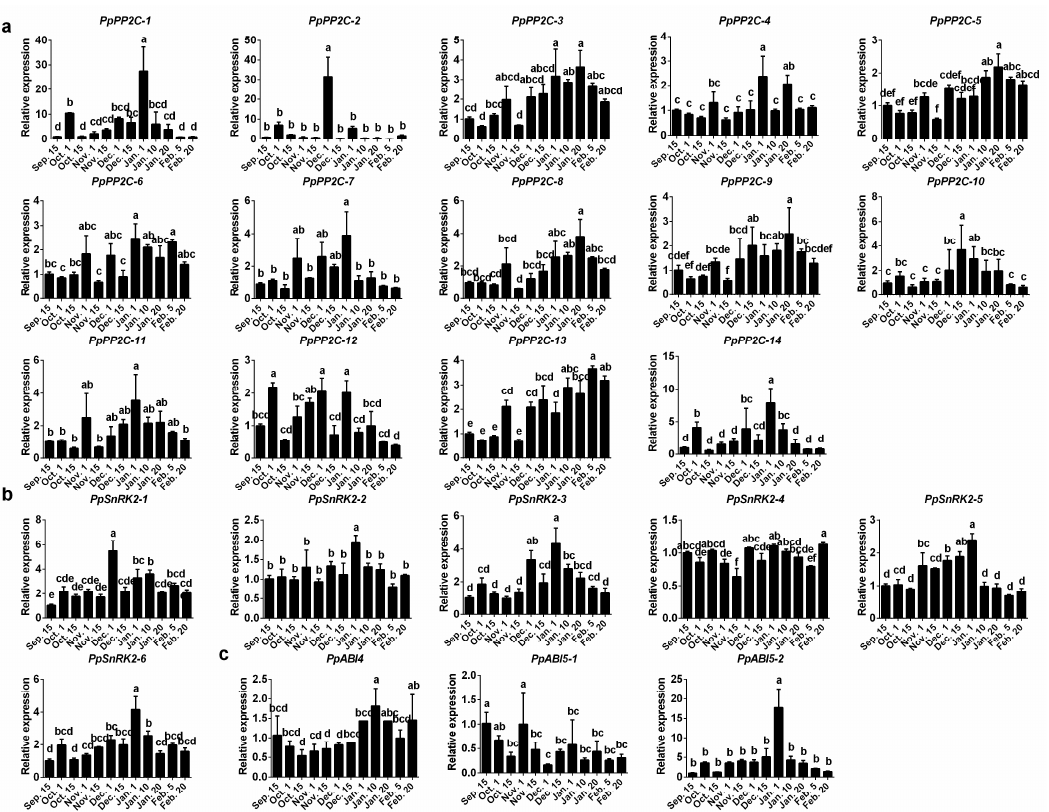
Figure 5. Relative gene expression levels of ABA signaling transduction genes (( a ) PP2Cs; ( b ) SnRK2s; ( c ) ABI4/ABI5) during flower bud dormancy on 2016–2017. Expression values were normalized to the value of the PpACTIN gene. Each bar represents the mean ± SEM of three biological replicates. Different letters indicate a significant difference among different dates ( p < 0.05).